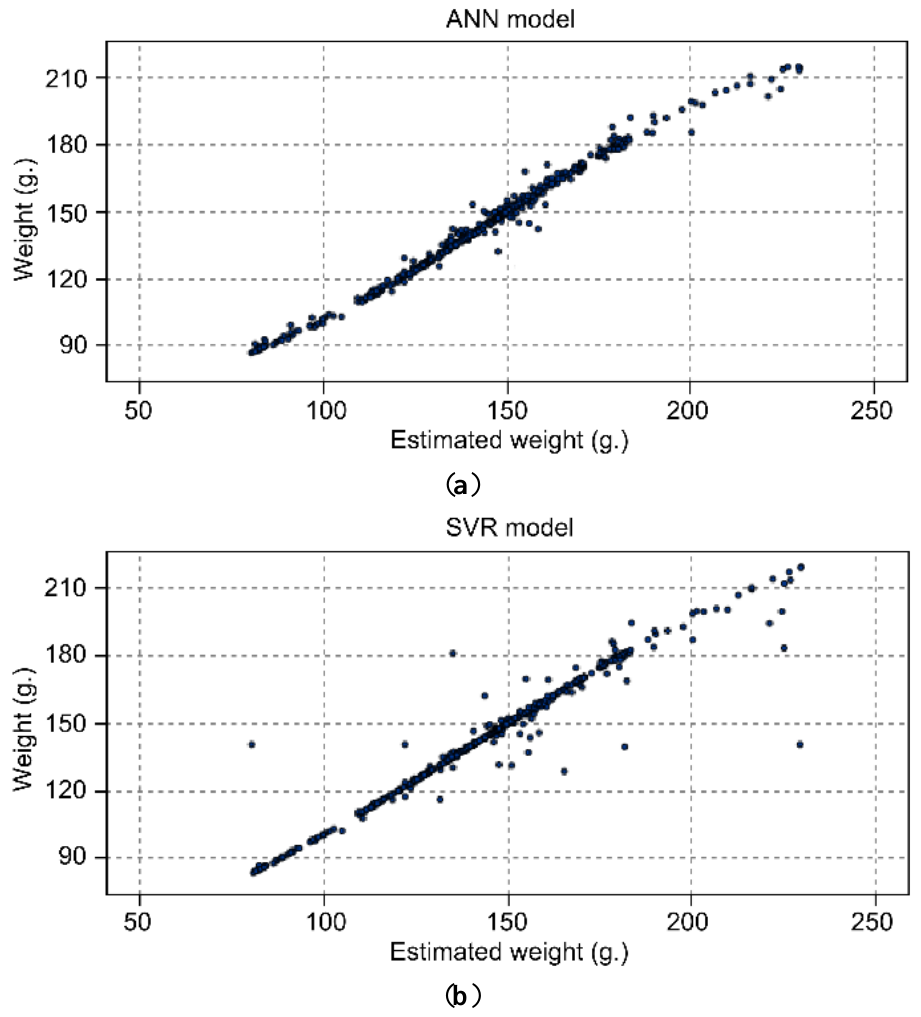
Figure 2. Comparison between real weight and estimated weight. ( a ) ANN model; ( b ) SVR